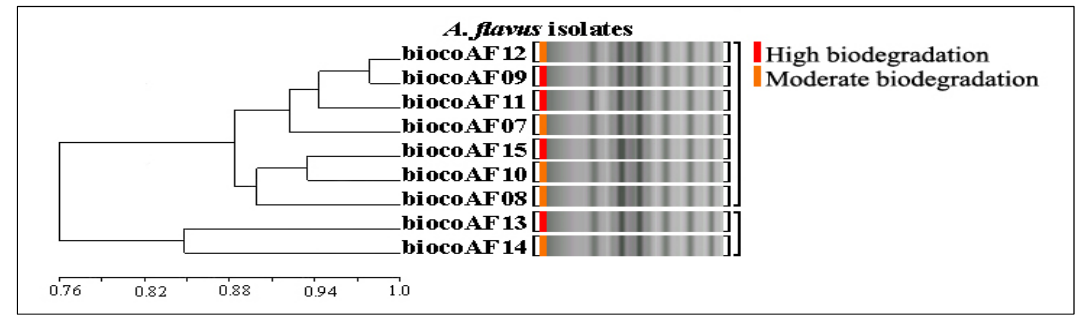
Figure 3. UPGMA dendrogram based on Jaccard’s coefficient illustrating the genetic